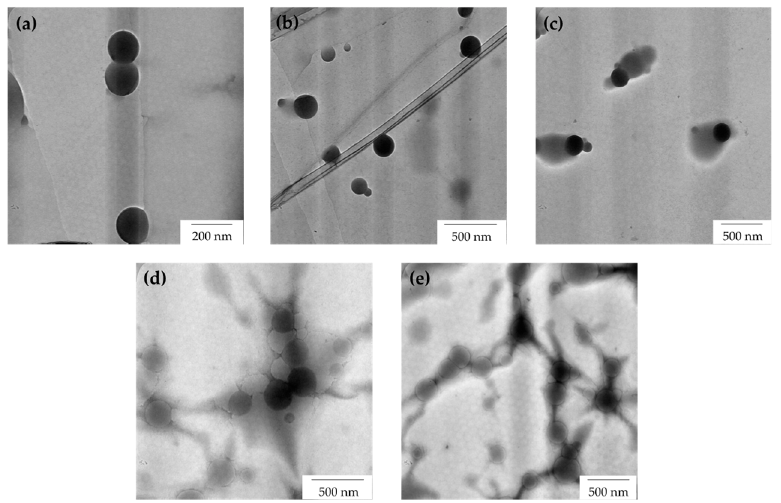
Figure 7. TEM images of AG-stabilized NRL with variable loadings of ( a ) 0.1 phr, ( b ) 0.2 phr, ( c ) 0.3 phr, ( d ) 0.4 phr, and ( e ) 0.5 phr before freezing.